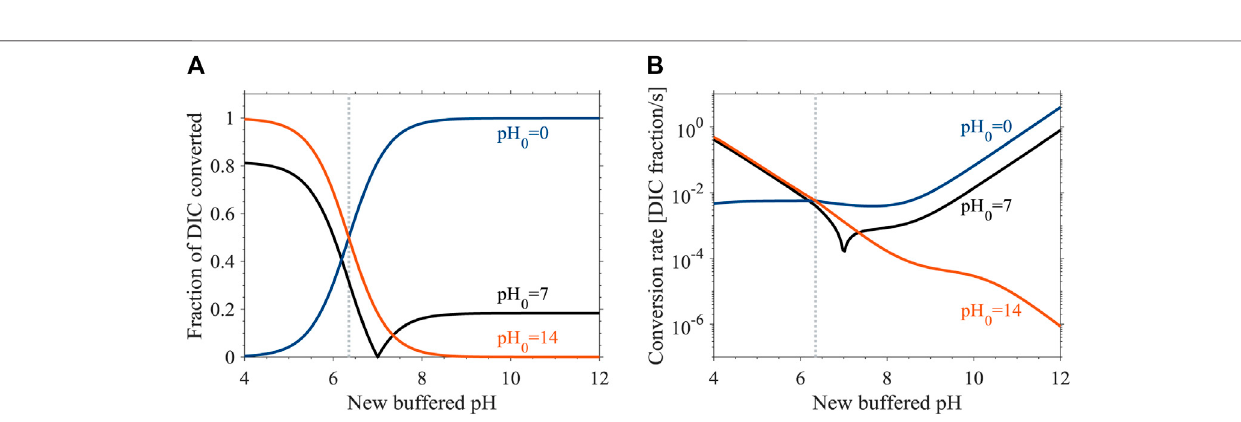
FIGURE2| Chemicalequilibration ofDICinpH-buffered freshwatersolutionsat25 ° C( Eq.13 ). (A) FractionsofDICconverted betweentheCO 2 (aq)- S poolsduring transitions from an initial pH 0 to a new equilibrium pH. (B) The average DIC conversion rates during these pH transitions.